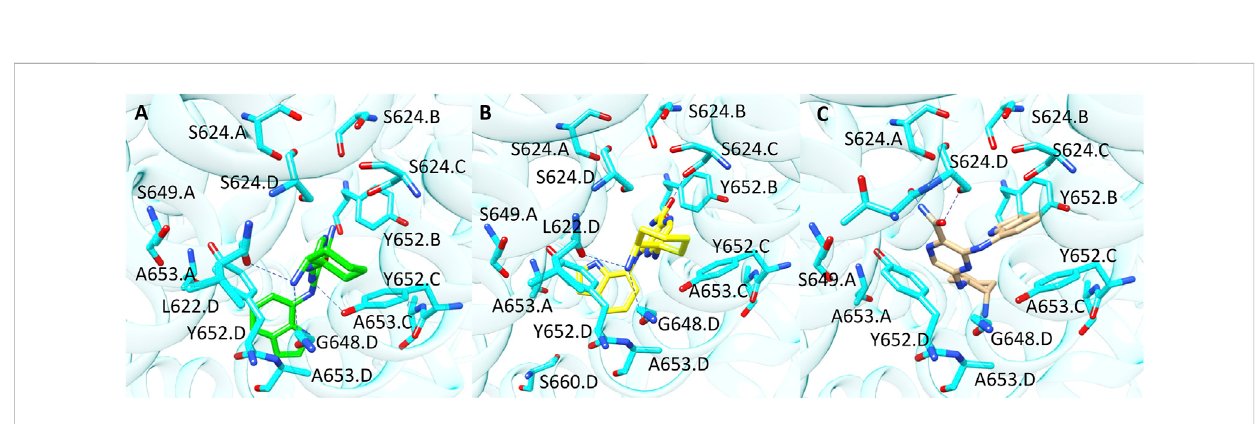
FIGURE 7 Binding modes of compound 9 into hERG binding site predicted by (A) GOLD, (B) PLANTS and (C) LiGen. H-bonds are represented as blue dashed